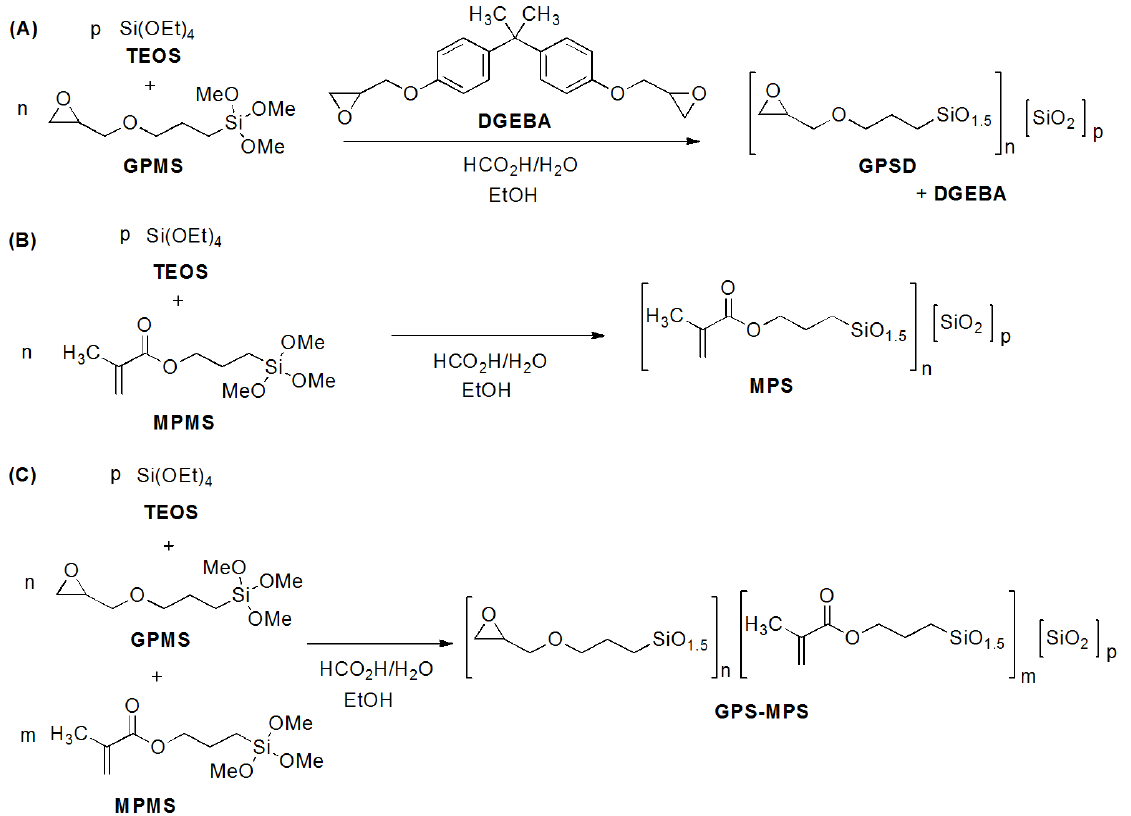
Figure 1. Preparation of GPSD [derived from ( γ -glycidyloxypropyl)trimethoxysilane (GPMS), tetraethoxysilane (TEOS) and diglycidyl ether of bisphenol A (DGEBA)] ( A ); MPS [derived from ( γ -methacryloxypropyl)trimethoxysilane (MPMS) and TEOS] ( B ) and GPS-MPS (derived from MPMS, GPMS and TEOS) ( C )